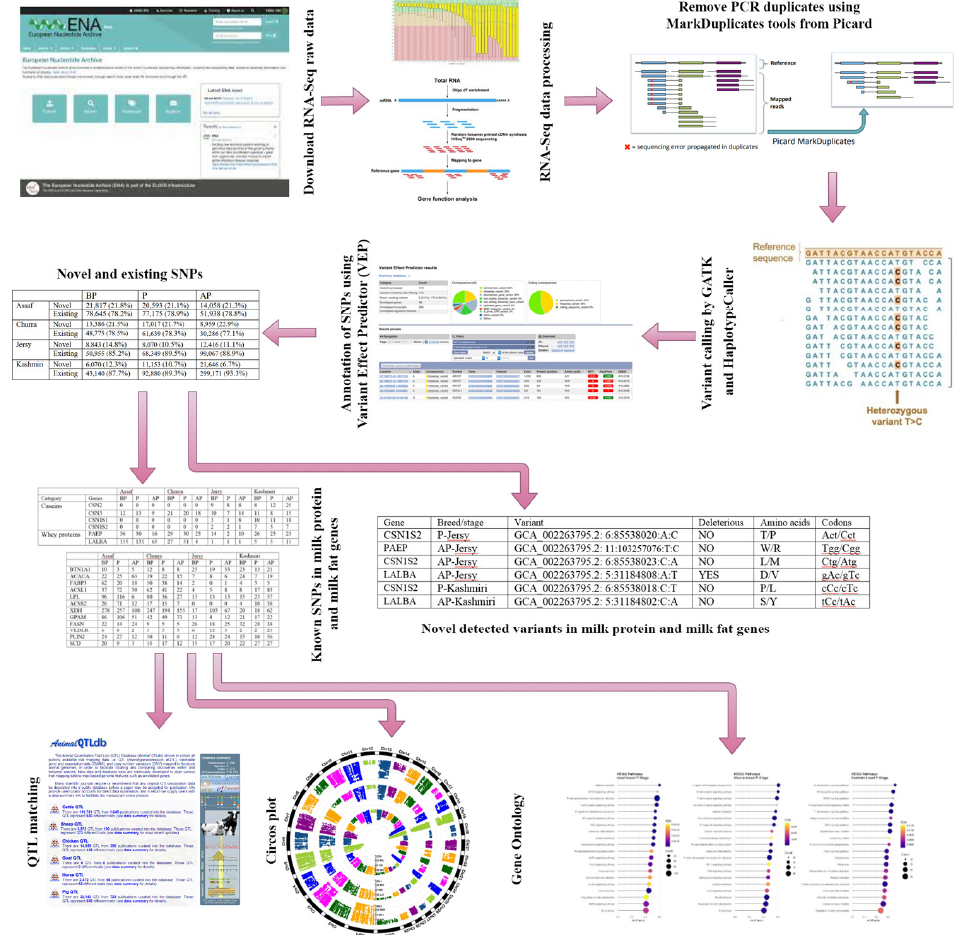
Figure 1. Graphical abstract of different bioinformatics analysis for SNP calling.